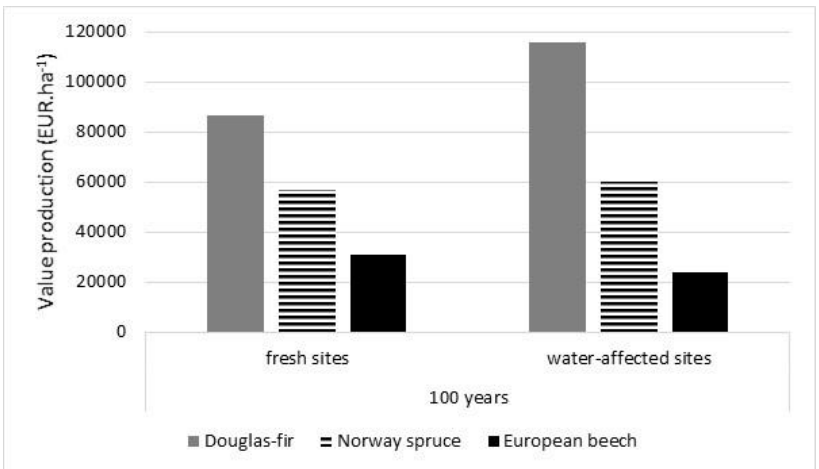
Figure 6. Value production at the age 100 years of Douglas fir, Norway spruce and European beech in fresh and water-affected sites.